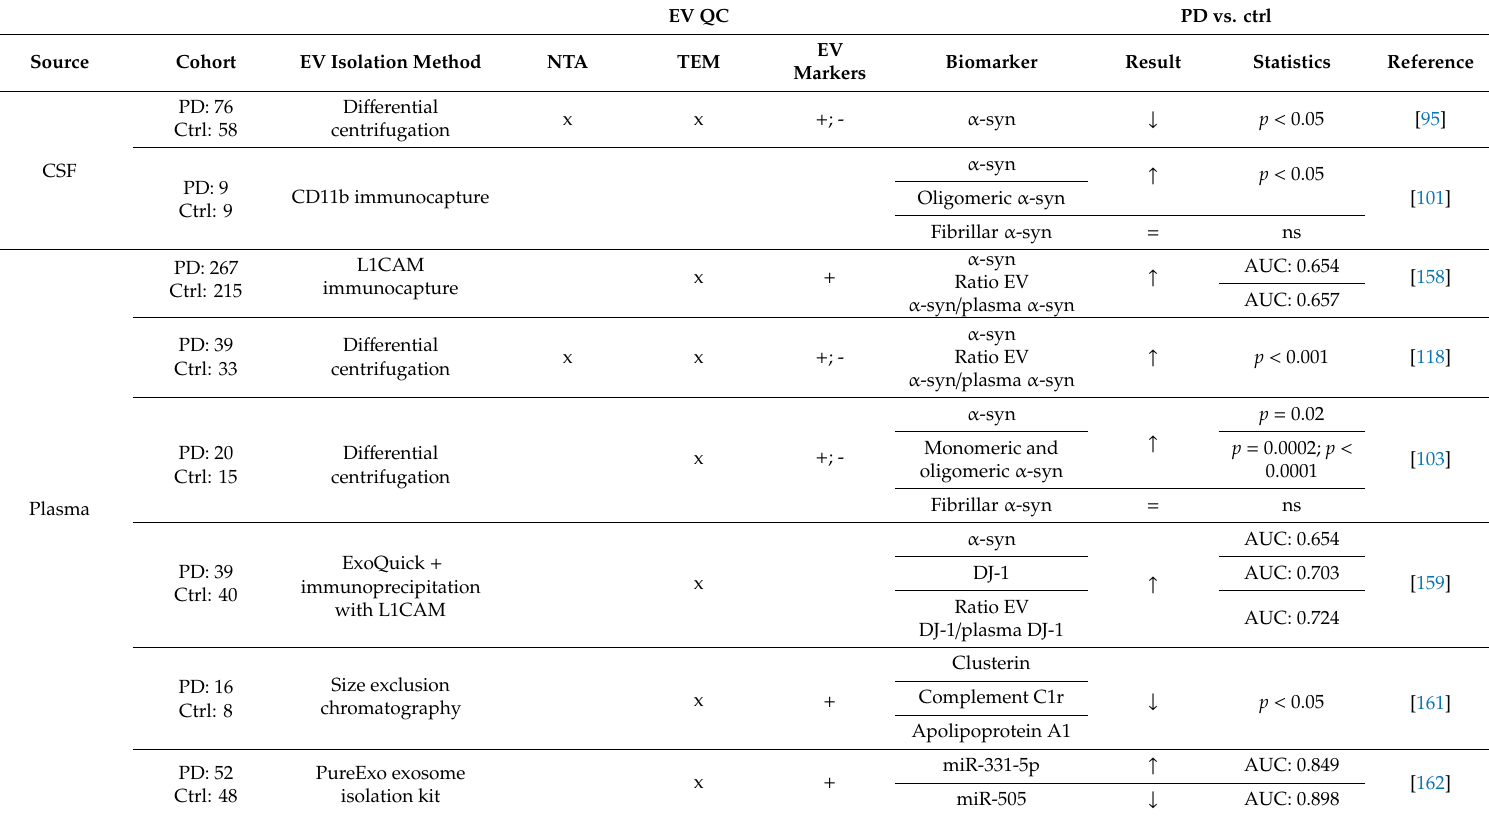
Table 2. Overview of extracellular vesicle (EV)-associated biomarkers in Parkinson’s disease (PD).